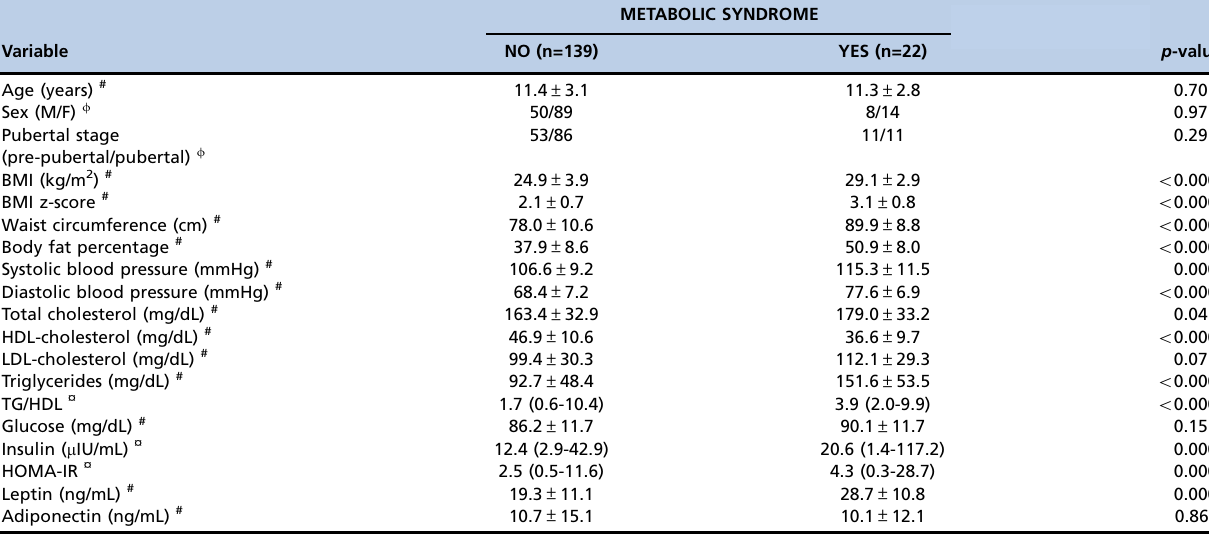
Table 5 - Clinical and laboratory characterization of individuals with and without metabolic